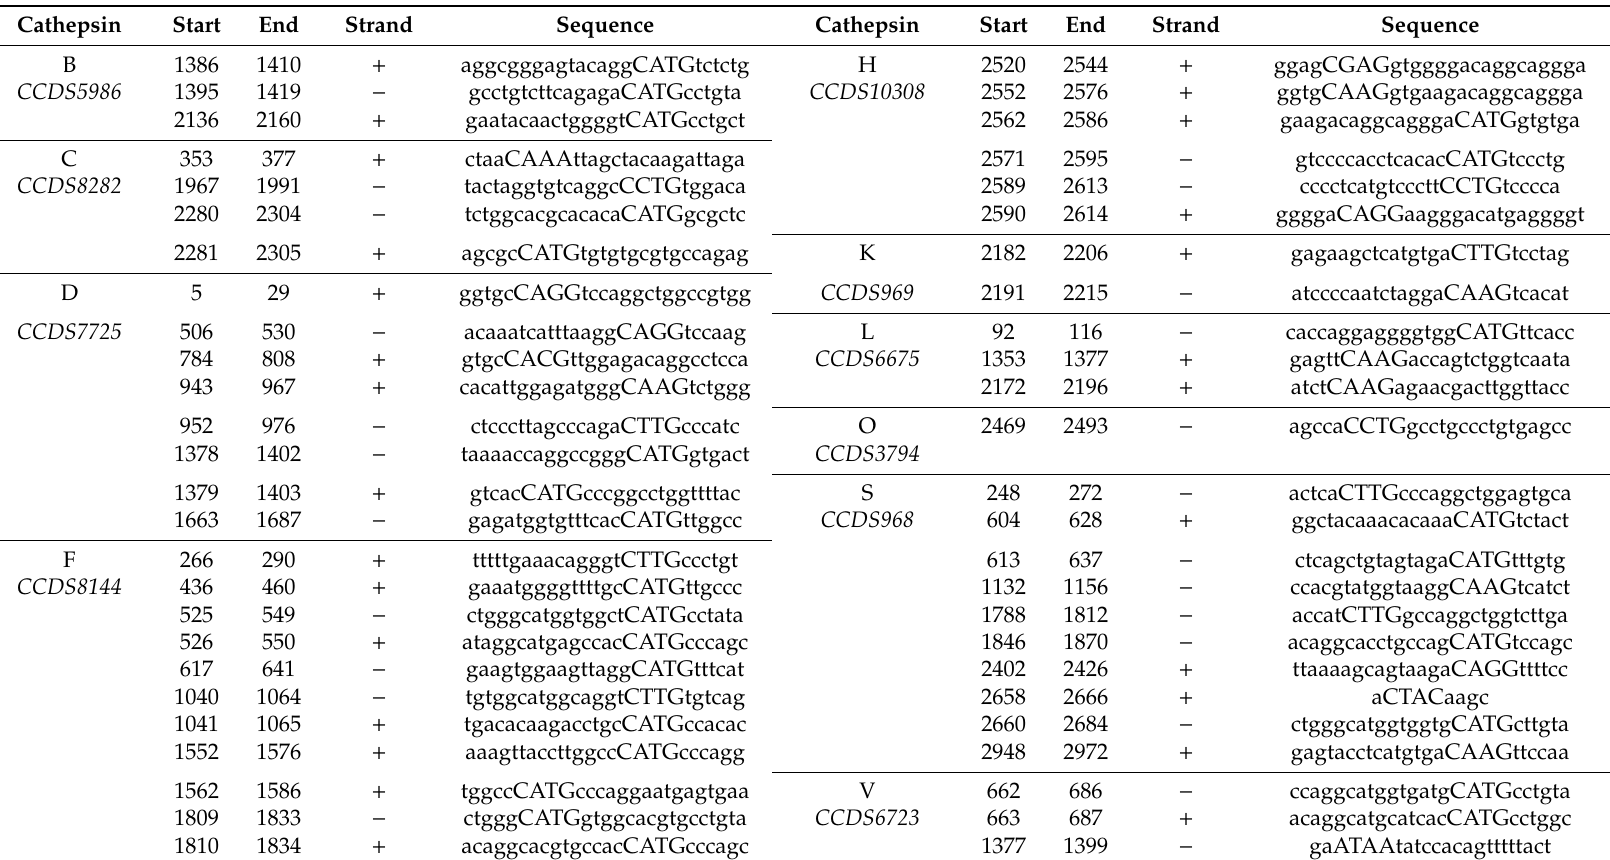
Table 4. Cathepsin proteases contain predicted p53 half-sequences with the upstream 3 kb regions of their transcription start sites. The 5 (cid:48) -3 kb regions for the shown cathepsin genes were taken from the Ensembl database using the show accession numbers (in italics), and a standard Matinspector search was performed to identify the location of the p53 consensus sites encoded on the positive or negative DNA